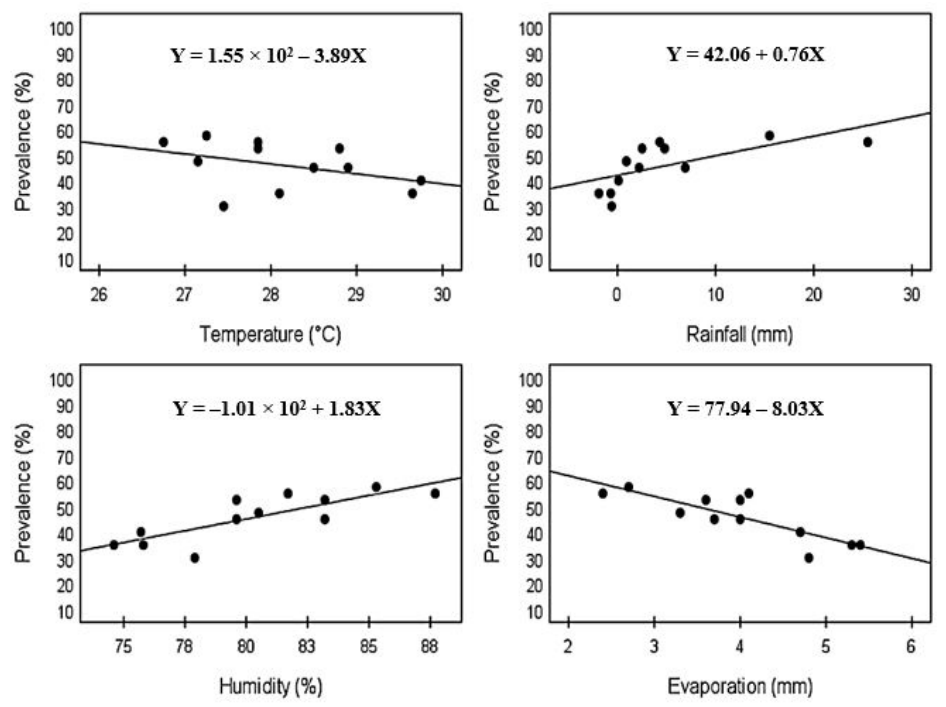
Figure 4. Scatter plot depicting the correlations between cattle fascioliasis and temperature (°C), rainfall (mm), humidity (%), and evaporation (mm).